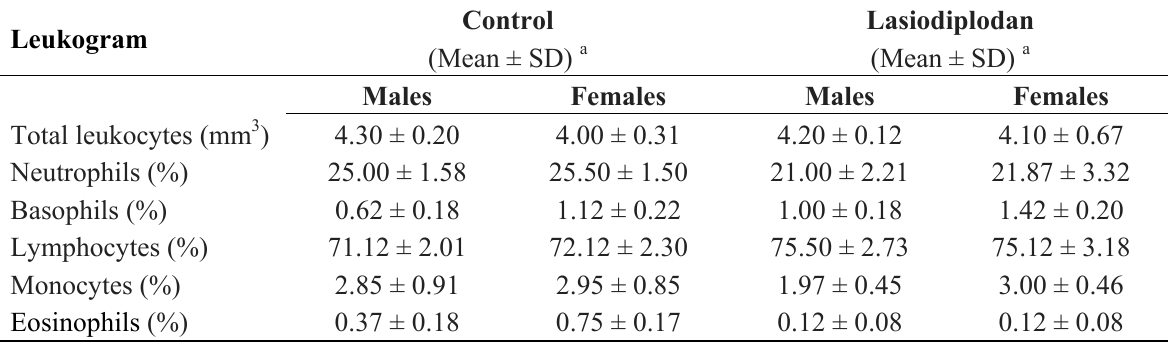
Table 2. Hematological parameters of male and female mice groups after a 28-day treatment with lasiodiplodan by